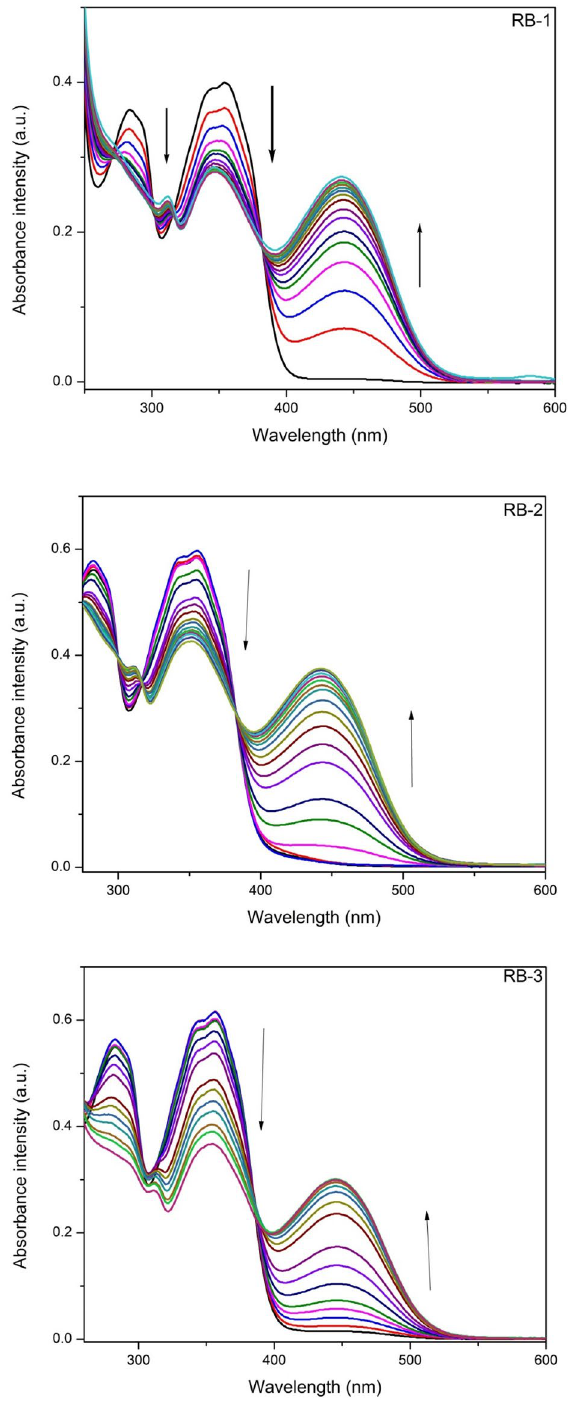
Figure 2. UV–Vis titration spectra of chemosensors RB-1, RB-2 and RB-3 in CH 3 CN after addition of F − ions (12